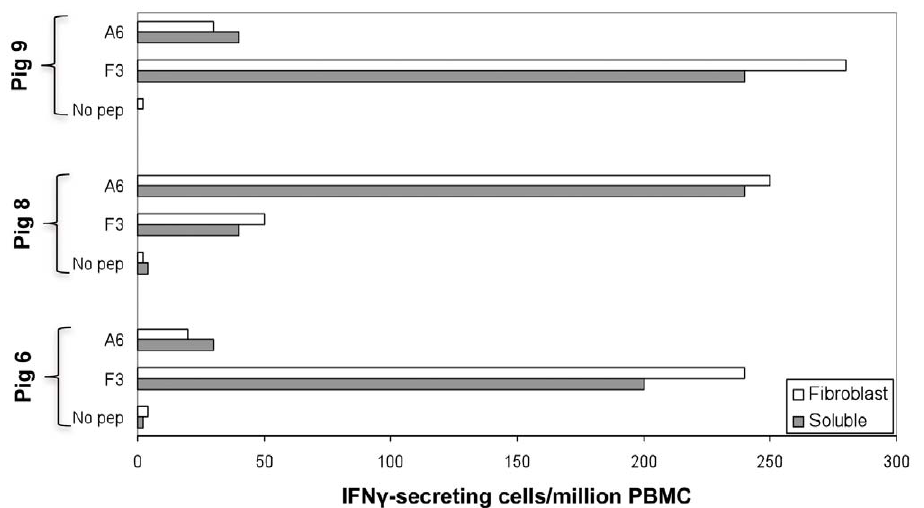
Figure 8. Identification of protective SLAI restricted 9-mer T-cell peptides. PBMCs from surviving pigs, pre-immunized with pCMV- UbsHAPQ (obtained at day 25 after ASFV lethal challenge), were in vitro stimulated with 53 9-mer peptides predicted as potential CTL epitopes. Data represented in grey boxes corresponds to the specific responses found for the two individual sHA epitopes: F3, and A6. Data represented in open boxes corresponds to the values obtained after in vitro stimulation with peptide-coated autologous SLAI + /SLAII 2 skin fibroblasts.